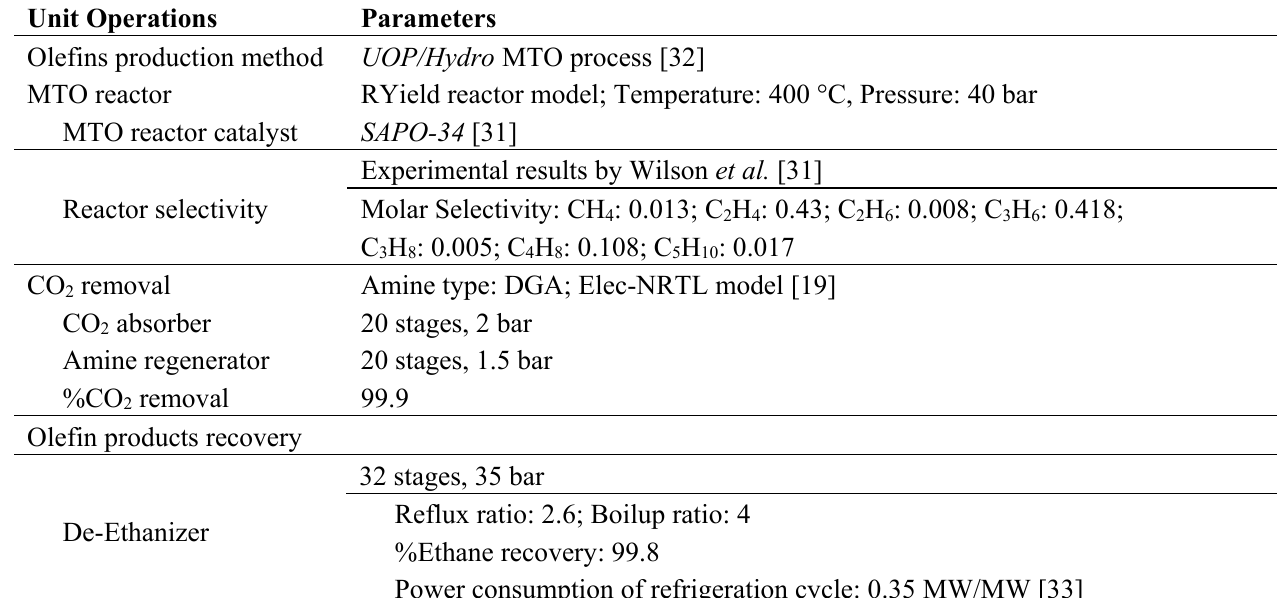
Table 4. Main design parameters of the MTO